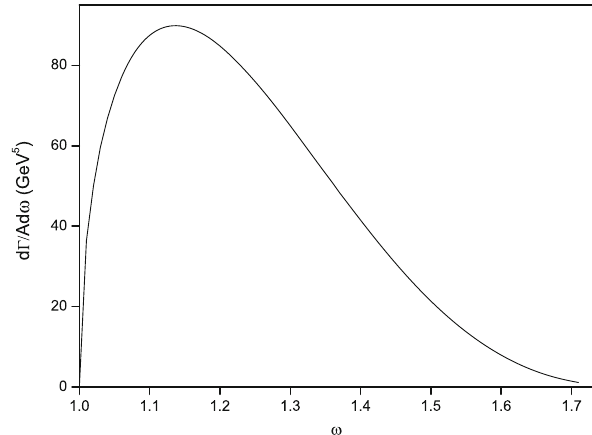
Fig. 2 The variation of differential decay rate for the Λ b → Λ c (cid:3) ¯ ν semileptonic decay